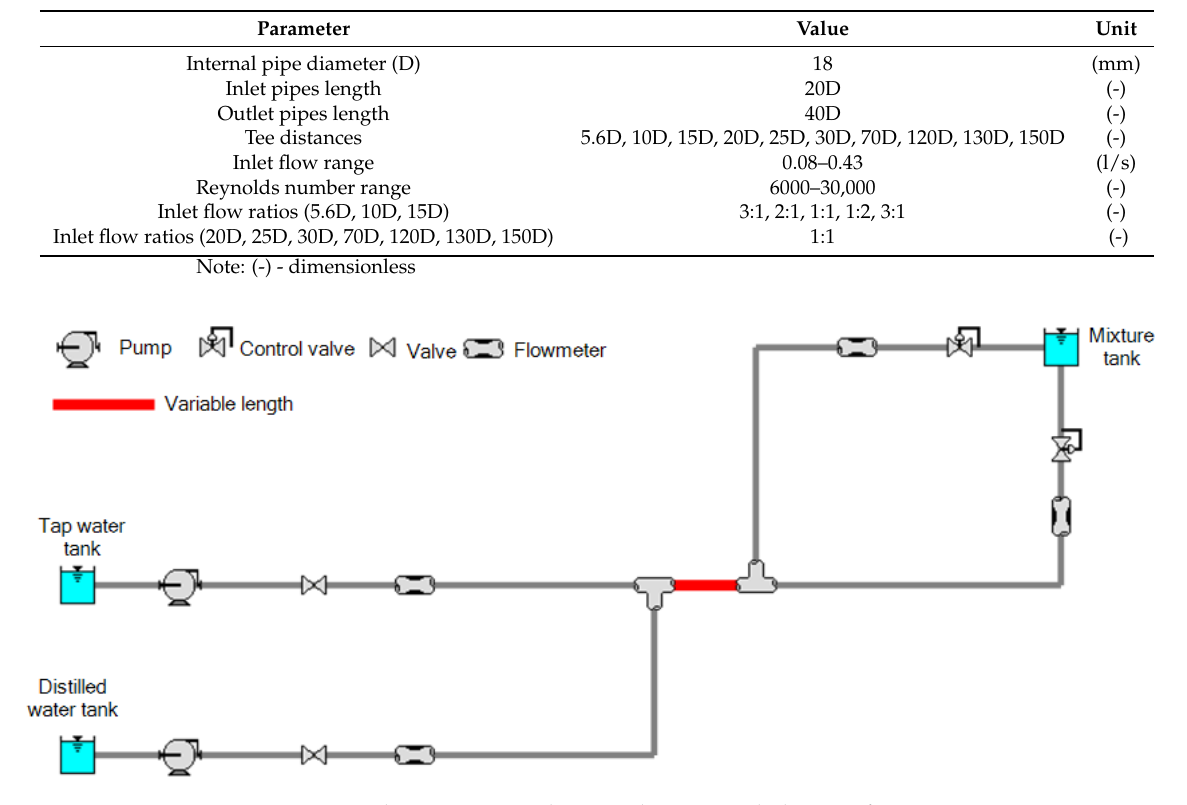
Figure 2. Complete experimental setup schematic with the S